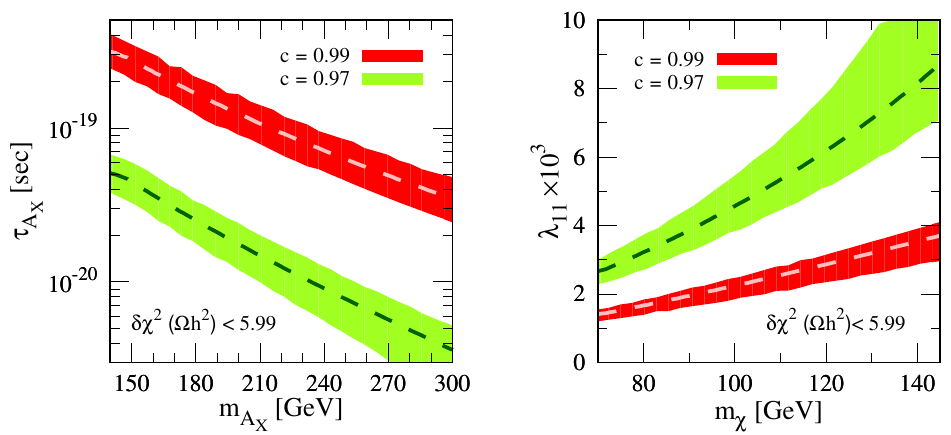
Figure 6 . Results of our numerical scan where we have applied a 95% con(cid:12)dence level on the relic density. Dashed lines correspond to analytical result applied approximation of eq. (4.27) with x f =